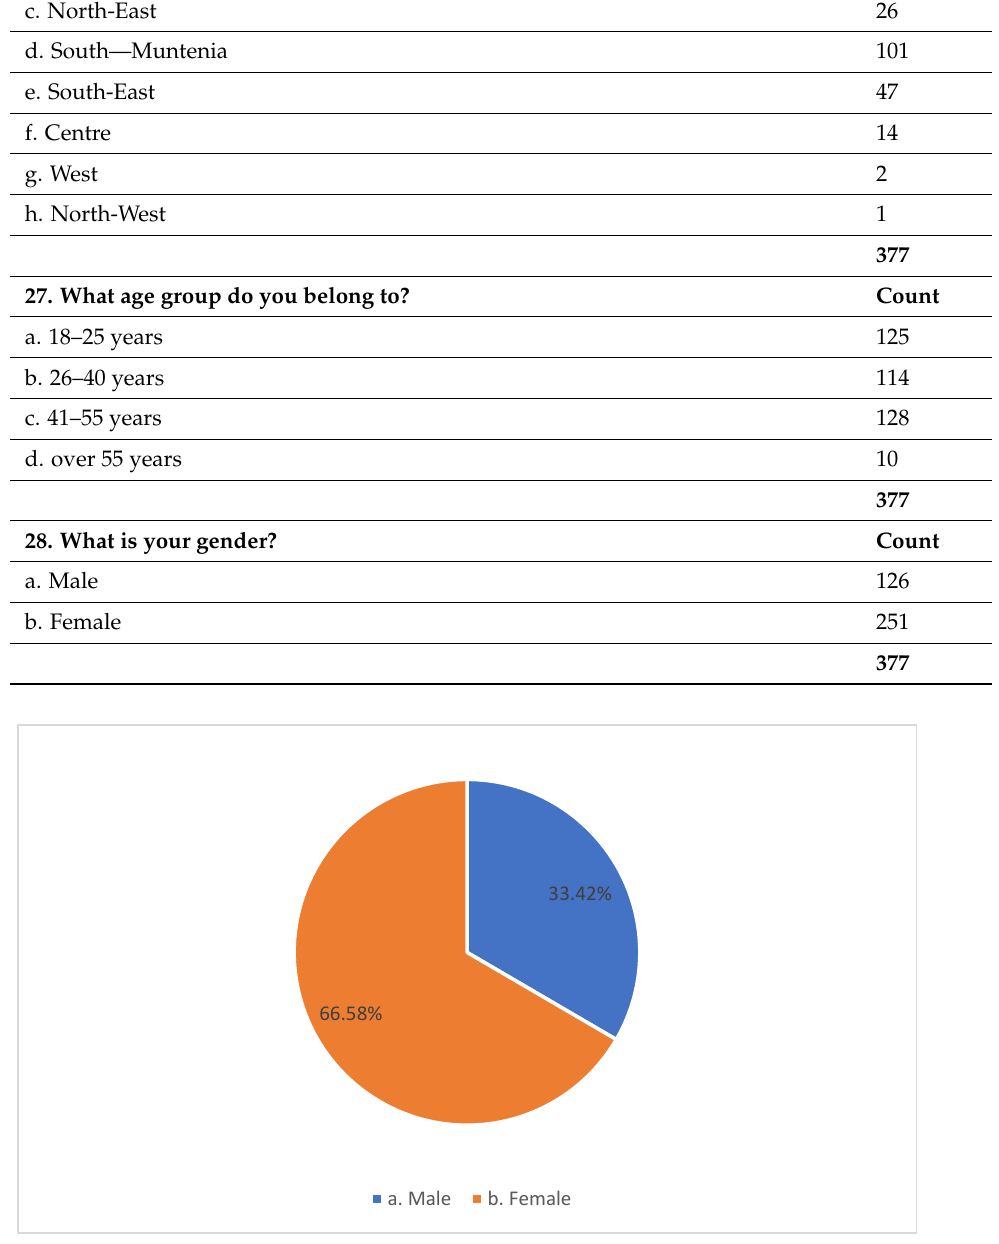
Figure A4. Gender of respondents.